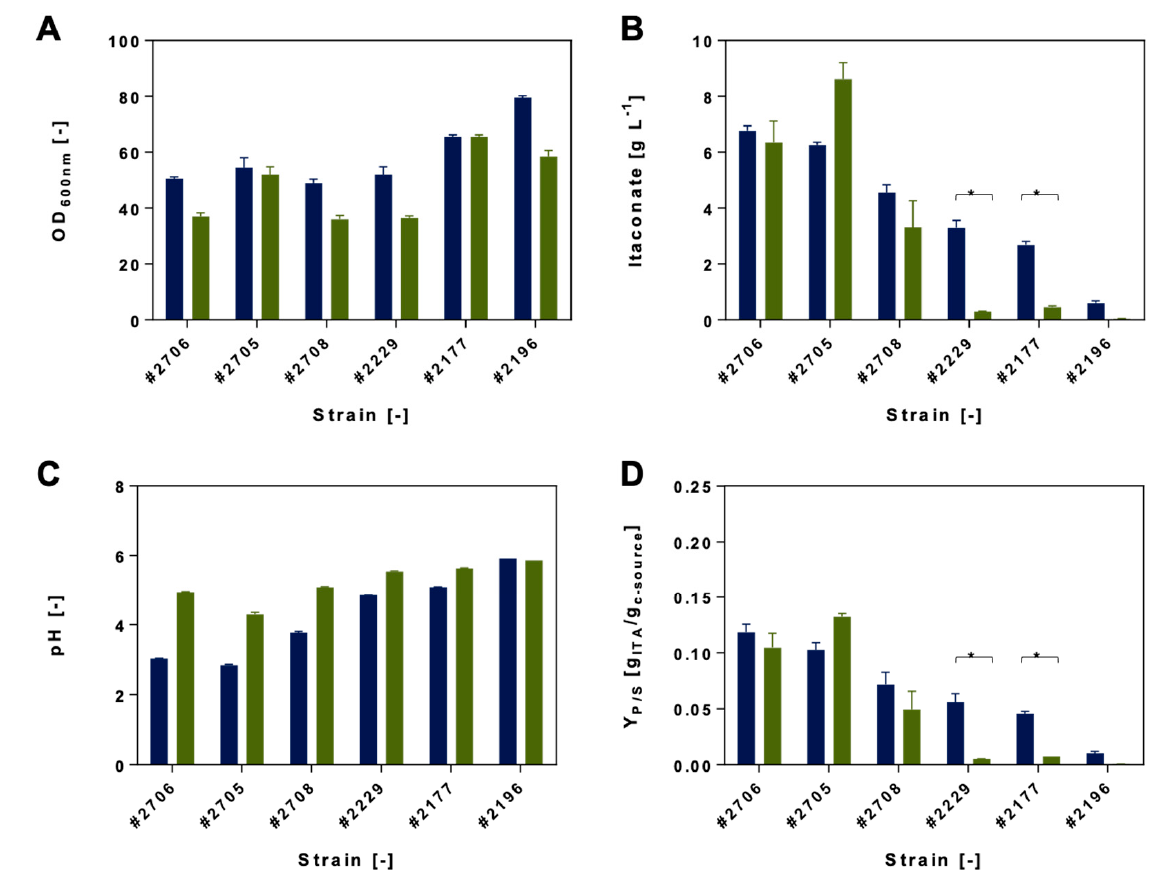
Figure 5. Itaconic acid production of selected Ustilaginaceae strains. ( A ) Max. optical density (OD 600 [ − ]), ( B ) maximum itaconic acid production [g L − 1 ], ( C ) minimum pH [ − ], and ( D ) Y P/S [g ITA /g c-source ] during System Duetz ® 24-deep-well plate cultivation experiments with 1.5 mL MTM medium and 0.8 g L − 1 NH 4 Cl. Ustilaginaceae candidates using formate as a co-substrate are shown in green (6.25 g L − 1 ). Respective glucose references (50 g L − 1 ) are shown in blue. Error bars indicate the deviation from the mean for n = 2. Statistically significant differences in itaconic acid production ( p ≤ 0.05) are indicated as * . Details of statistical analyses are displayed in Tables S11 and